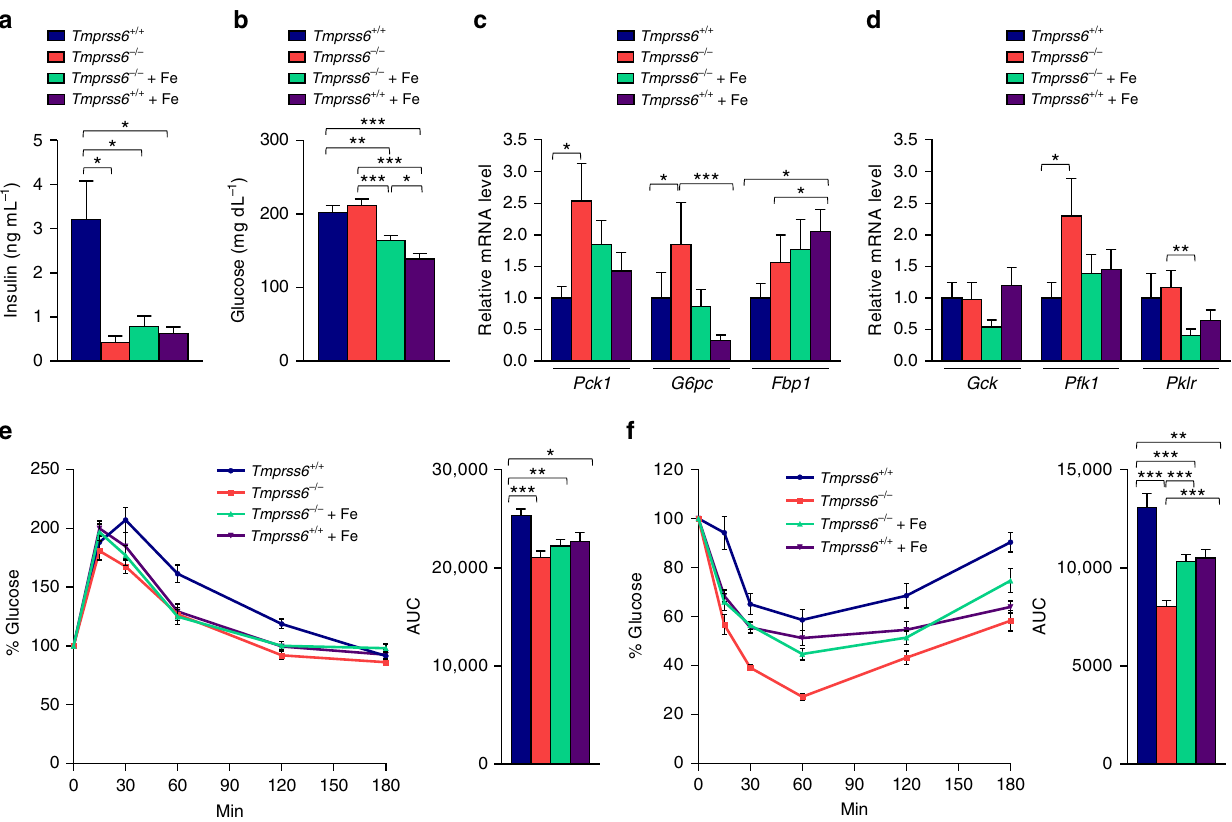
Fig. 4 Improved glucose metabolism in HFD-fed Tmprss6 -de fi cient mice. a Fasting plasma concentration of insulin in HFD-fed Tmprss6 + / + ( n = 10), Tmprss6 − / − ( n = 6), and both iron-treated Tmprss6 − / − and Tmprss6 + / + mice ( n = 8 and n = 6 respectively). b Fasting blood glucose concentration in HFD-fed Tmprss6 + / + ( n = 11), Tmprss6 − / − ( n = 13), and both iron-treated Tmprss6 − / − and Tmprss6 + / + mice ( n = 13 and n = 10 respectively). Relative expression levels of genes related to gluconeogenesis ( c ) and glycolysis ( d ) in liver samples from HFD-fed Tmprss6 + / + ( n = 11), Tmprss6 − / − ( n = 8 – 9), and both iron-treated Tmprss6 − / − and Tmprss6 + / + mice ( n = 10-11 and n = 8 respectively). e Glucose tolerance test after overnight fasting in HFD-fed Tmprss6 + / + ( n = 11), Tmprss6 − / − ( n = 12), and both iron-treated Tmprss6 − / − and Tmprss6 + / + mice ( n = 9 and n = 9 respectively). f Insulin tolerance test after overnight fasting in HFD-fed Tmprss6 + / + ( n = 11), Tmprss6 − / − ( n = 12), and both iron-treated Tmprss6 − / − and Tmprss6 + / + mice ( n = 13 and n = 11 respectively). AUC, area under the curve. Data shown are mean ± SEM. * P < 0.05, ** P < 0.01, *** P < 0.001, two-tailed Student ’ s t test